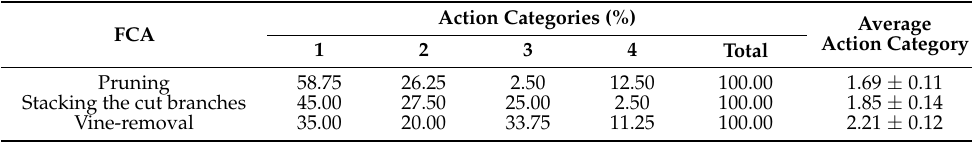
Table 4. Percentage of working posture action categories in